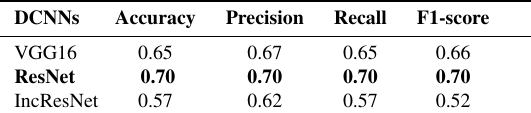
Table 2. Overall classification results comparing the three different